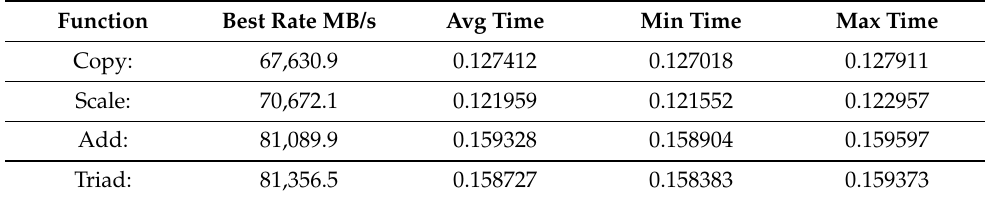
Table 4. Streaming results with OMP NUM THREADS = 10.